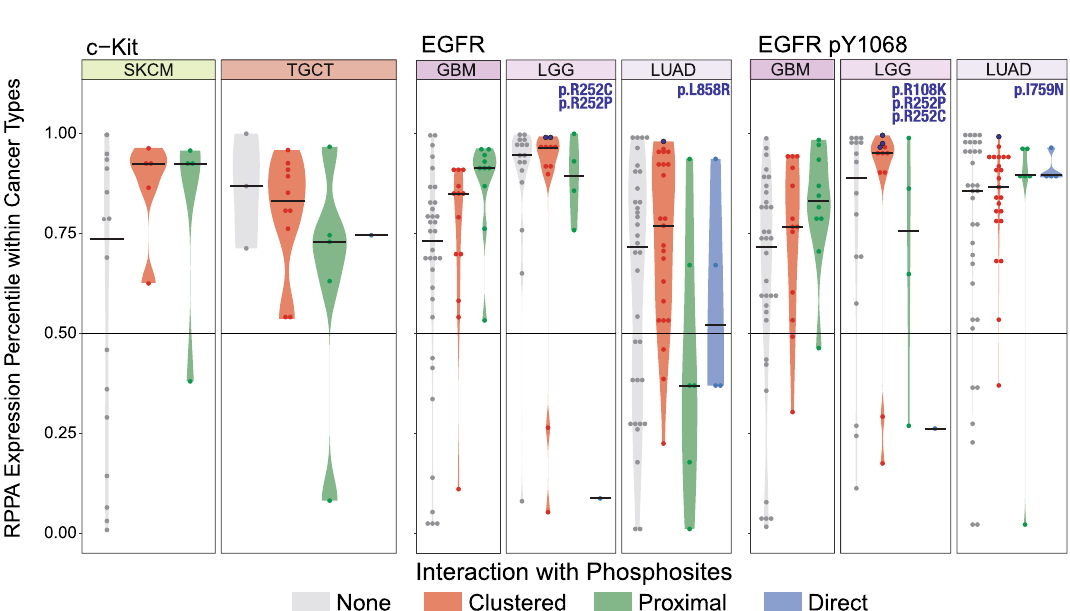
NATURE COMMUNICATIONS| (2021) 12:2313